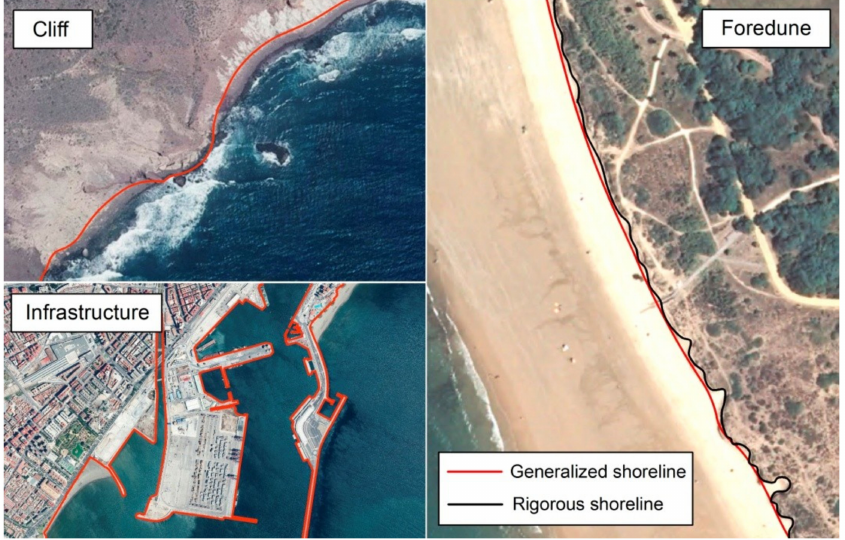
Figure 4. Digitization criteria of the proxy